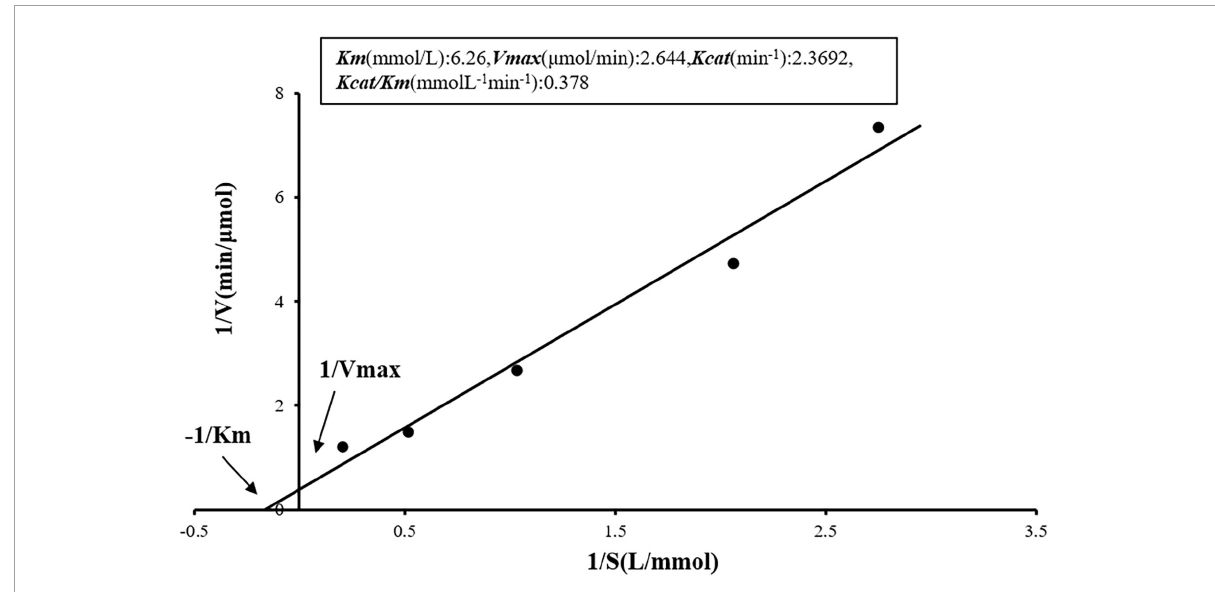
FIGURE8 Kinetic analysis of the enzymatic reaction of prot DS5. The enzyme concentration (0.81 mg/ml) was used in the detection. Inset: Kinetic parameters of prot DS5.